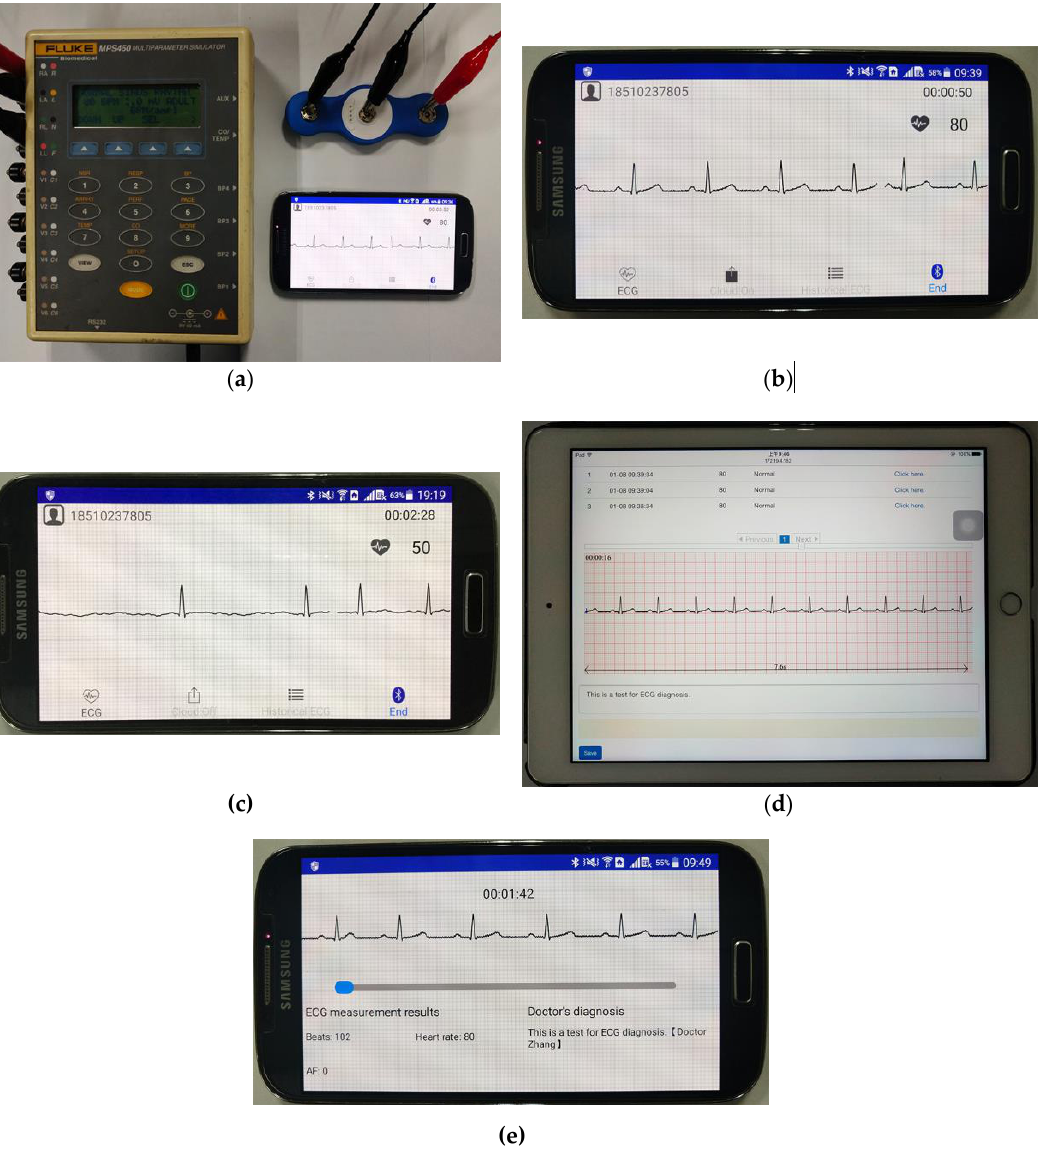
Figure 11. The ECG monitoring system in operation. ( a ) The ECG patch was connected to the FLUKE MPS450. ( b , c ) The Android APP displayed the normal ( b ) and abnormal ( c ) ECG waveforms in real time. ( d ) The doctor’s web browser displayed the 30 s ECG waveforms. ( e ) The historical data module